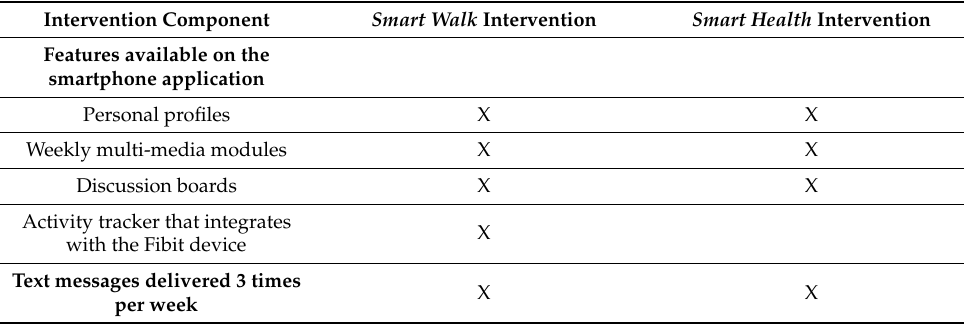
Table 4. Comparison of Smart Walk and Smart Health intervention